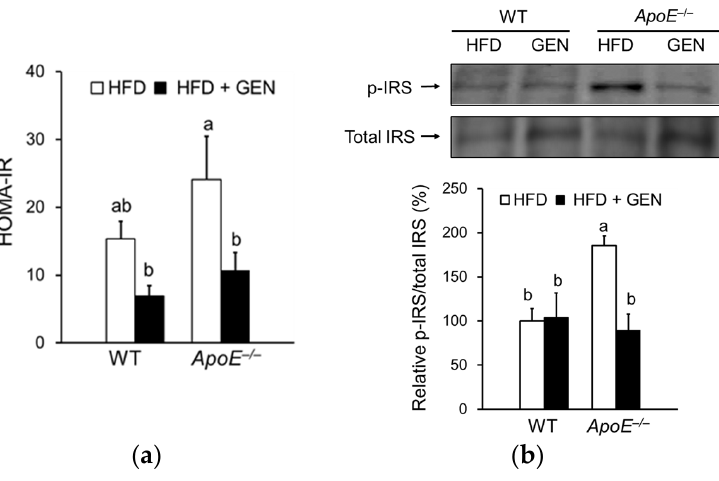
Figure 2. Effects of genistein on insulin resistance of WT and ApoE − / − mice fed an HFD. ( a ) Homeostasis model assessment of insulin resistance (HOMA ‐ IR) was calculated based on serum glucose and insulin levels ( n = 5–7); ( b ) relative protein levels of phosphorylated insulin receptor substrate (p ‐ IRS) in the cortex and hippocampus were analyzed by immunoblotting and were normalized to total IRS ( n = 3). Each bar represents the mean ± SEM and bars with different superscripts are significantly different at p < 0.05.